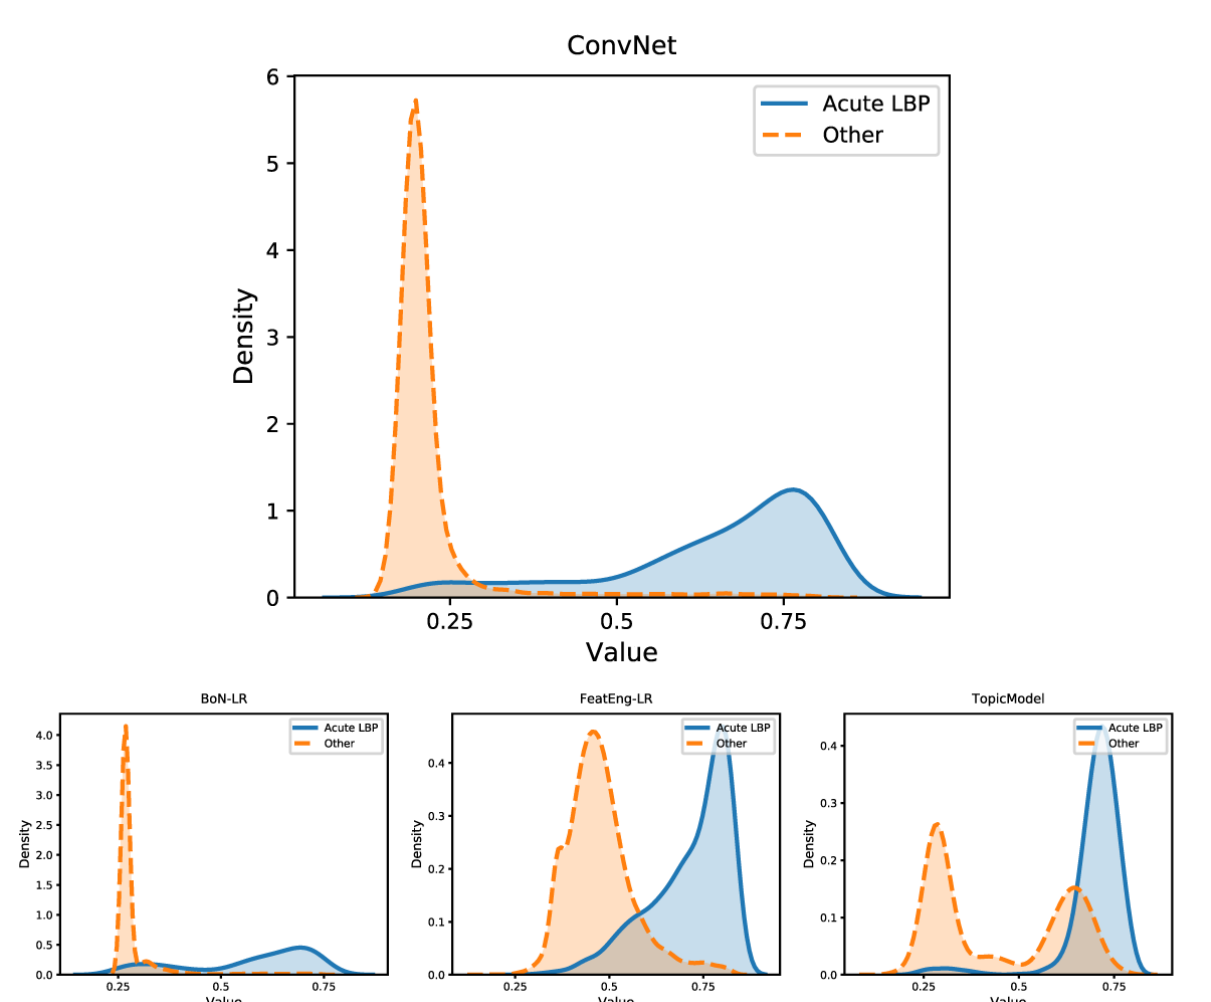
Figure 4. Representation of the probability distribution of the scores obtained by BoN-LR, FeatEng-LR, ConvNet, and TopicModel. ConvNet led to a good separation between acute low back pain clinical notes and all the other documents. In other cases, such separation is not as clear, explaining the worse classification results obtained by those models. BoN-LR: logistic regression with bag of n-grams; ConvNet: convolutional neural network-based architecture; FeatEng-LR: logistic regression with feature